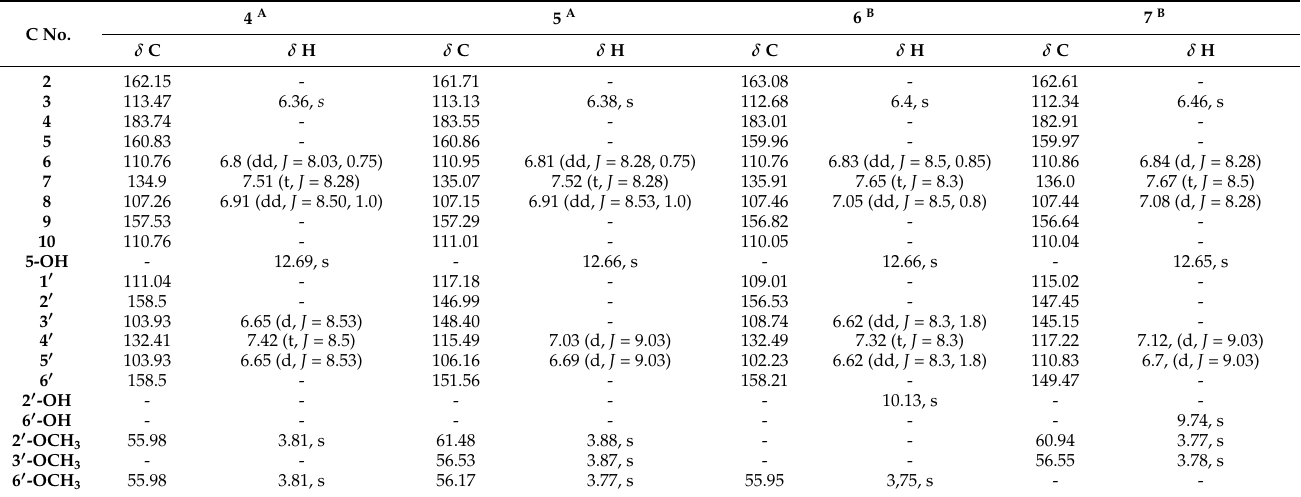
Table 1. 1 H and 13 C spectral data of compounds 4–7 (400 Hz for 1 H and 100 Hz for 13 C spectrum, δ in ppm, J in